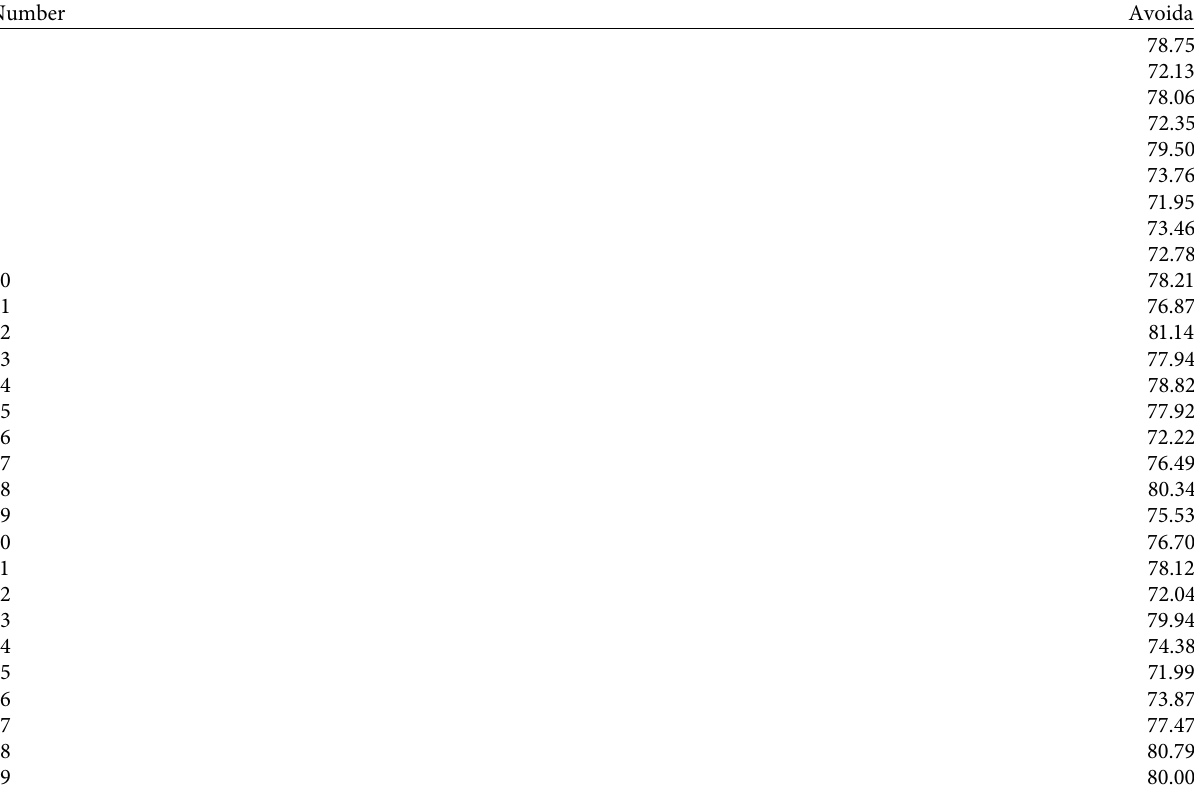
Table 2: Obstacle avoidance efects of robots based on deep learning.